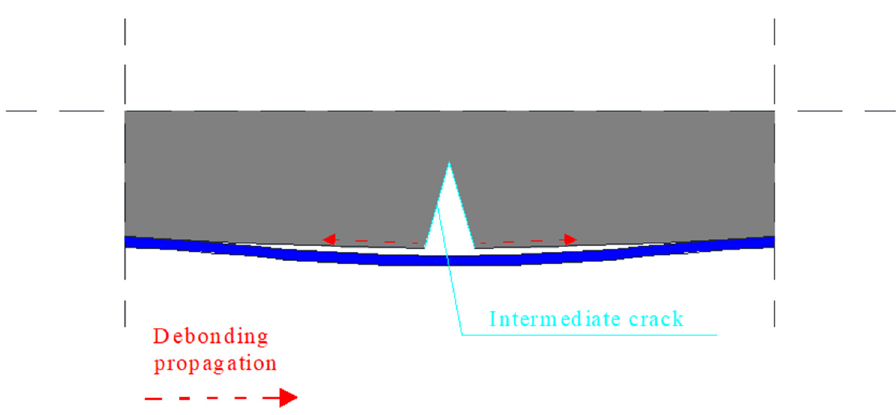
Figure 3. Debonding due to vertical cracks.